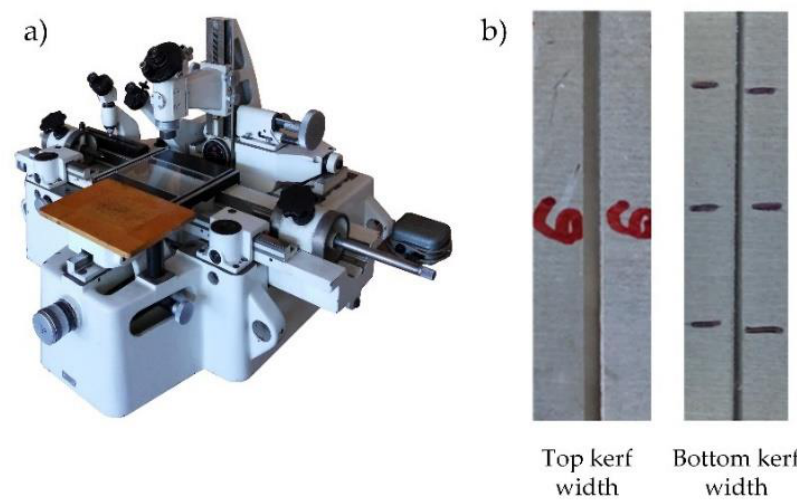
Figure 3. ( a ) Universal Toolmaker’s Microscope and ( b ) example of top and bottom kerf width. Table 4. Specifications of Universal Toolmaker’s Microscope.